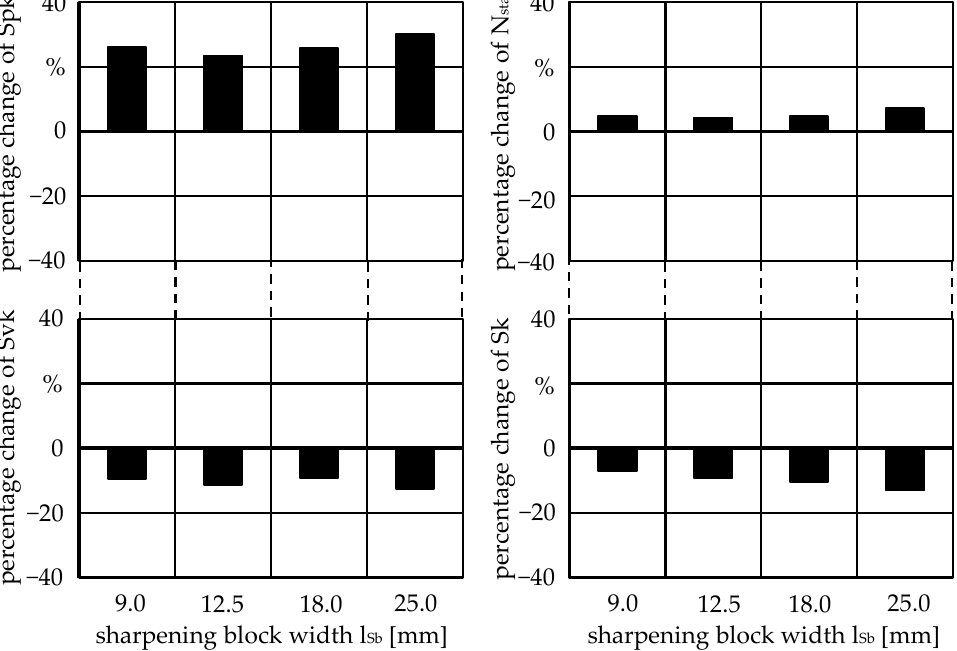
Figure 10. Influence of the sharpening block width l Sb on the topography characteristics.